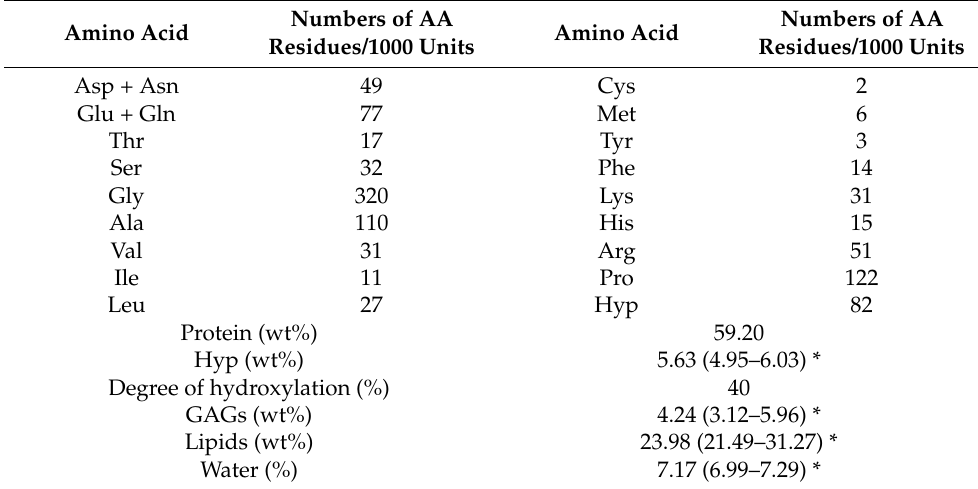
Table 1. Composition of COL lyophilizate isolated from porcine skin. “*” represents the lower and upper quartiles.